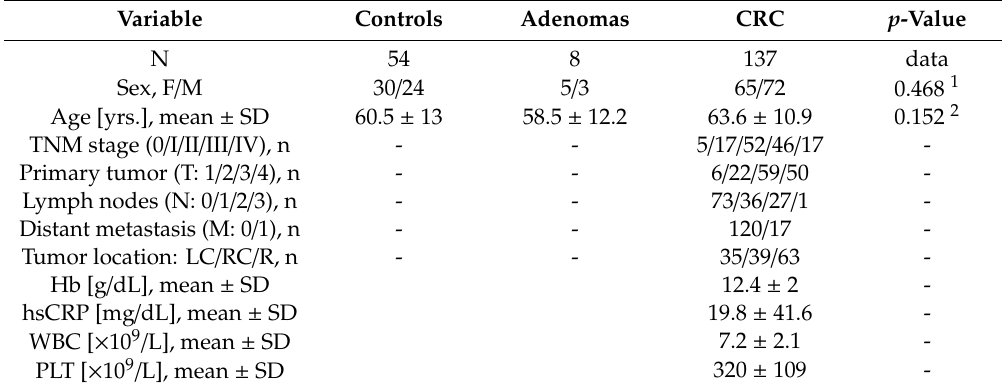
Table 1. Basic demographic and clinicopathological characteristics of the study population. Variable Controls Adenomas CRC p